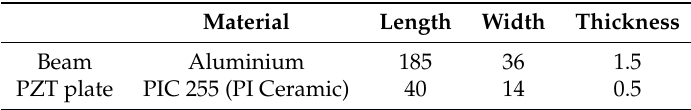
Table 1. Cantilever beam and lead zirconate titanate (PZT) plate specifications, and lengths are expressed in